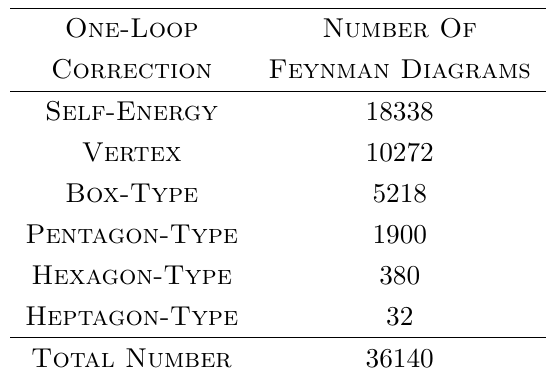
Table 1 . Number of one-loop Feynman diagrams for the dominant gg → e + ν e µ − ¯ ν µ b ¯ b τ + τ − partonic subprocess at O ( α 3 α 6 ) for the pp → e + ν e µ − ¯ ν µ b ¯ b τ + τ − + X process. The Higgs boson s exchange contributions are not considered and the Cabibbo-Kobayashi-Maskawa mixing matrix is kept diagonal.